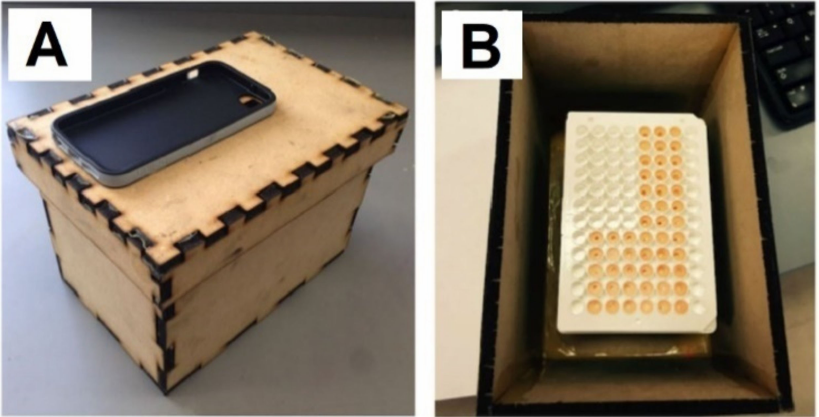
Figure 6. ( A ) The overview of the wooden dark-box with the iPhone case attached on the top so that the phone’s camera can take a picture of the solution plate inside. ( B ) The 96-well plate containing the detecting reagent and the sample is placed inside the box for taking chemiluminescent images